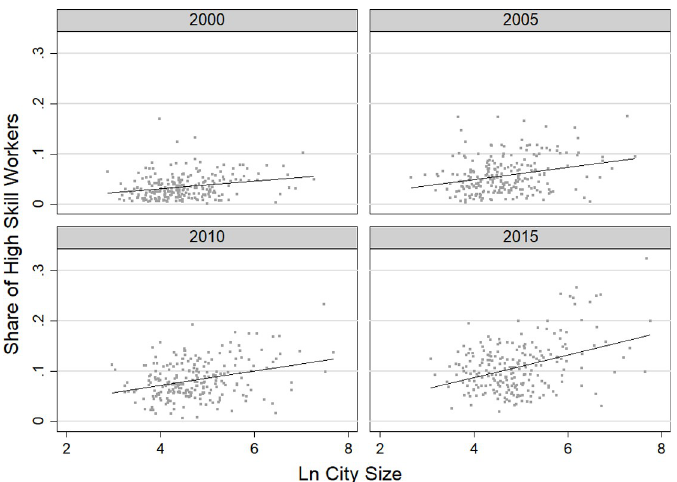
Fig 2. Changes in the spatial sorting trend of migrants from 2000 to